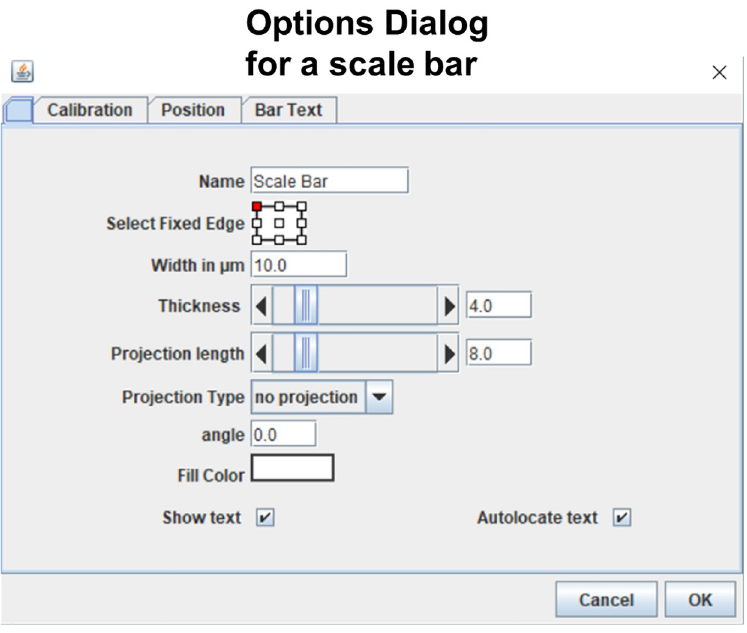
Fig 4. Objects can be edited with dialogs. Screenshot shows the dialog for one item (scale bar). Every option related to scale bar editing is listed by name in the dialog.